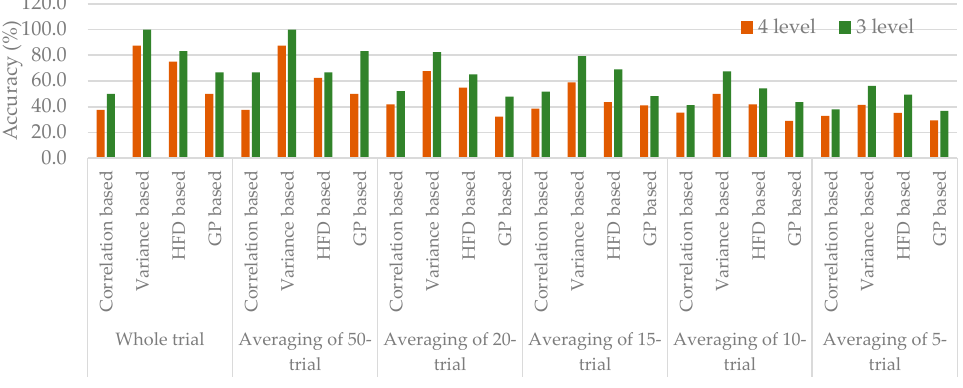
Figure 6. Classification accuracy (%) of n ‐ trial averaging with different feature groups.